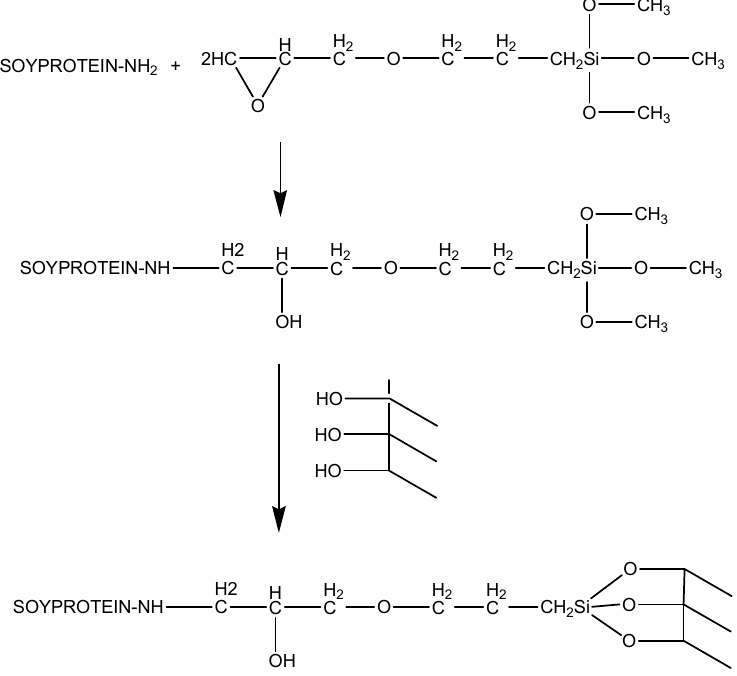
Figure 20. Silanation of soy protein for improving interfacial adhesion in glass fiber reinforced composites. Adapted from [79], with permission from Elsevier and Copyright Clearance Center, 2002.